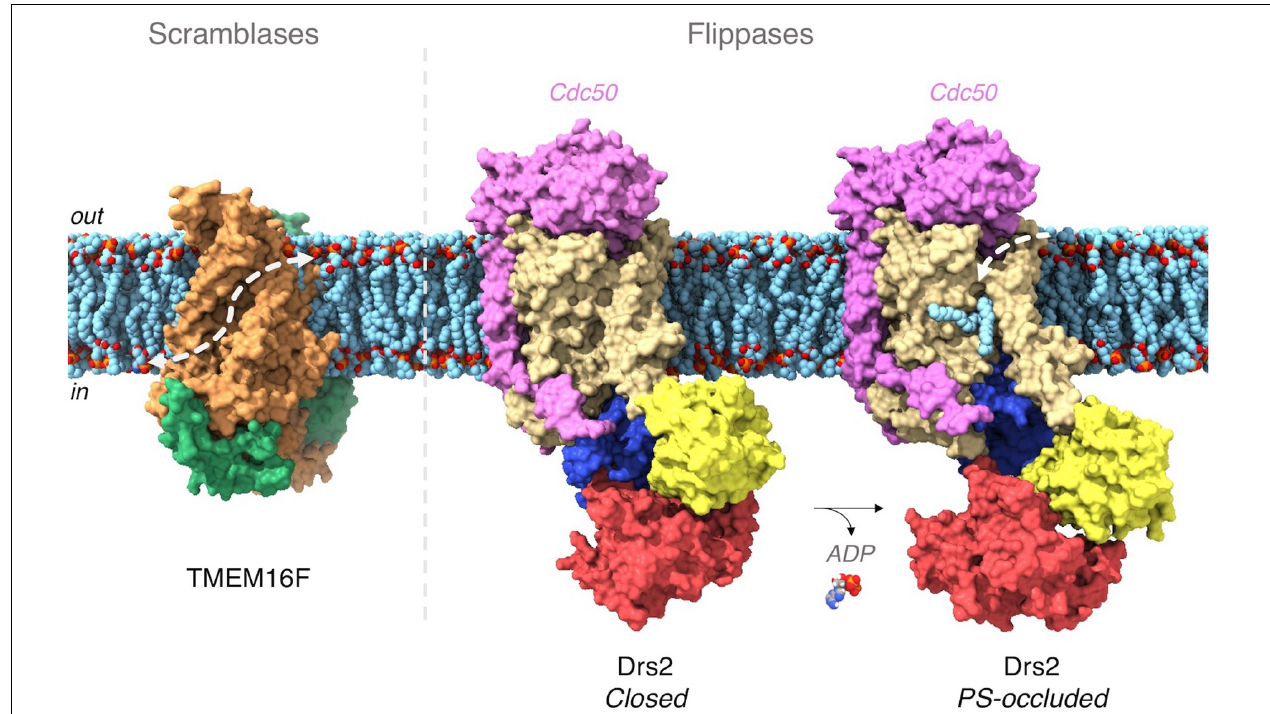
FIGURE 3 | Lipid transport pathway in TMEM16 scramblases and P4-ATPase flippases. In TMEM16 proteins, each monomer (in green and orange, respectively) harbors a cavity (underscored by the dashed white arrow) lined by hydrophilic residues and forming a groove through which lipid headgroups can transit from one leaflet to the other – known as the credit-card model (Pomorski and Menon, 2006). In P4-ATPases, ATP binds to the nucleotide binding domain (in red). The bound ATP molecule then phosphorylates a conserved aspartate in the phosphorylation domain (in blue). Phosphorylation triggers a rotation of the actuator domain (in yellow) which leads to the opening of a lipid hemichannel toward the exoplasmic side of the membrane. The Cdc50 subunit of Drs2 is in pink. (PDB codes used for this figure, nhTMEM16F: 4WIT, Drs2/Cdc50: 7OH7 (closed), 7OH6 (PS-occluded). The figure was generated with ChimeraX (Pettersen et al.,